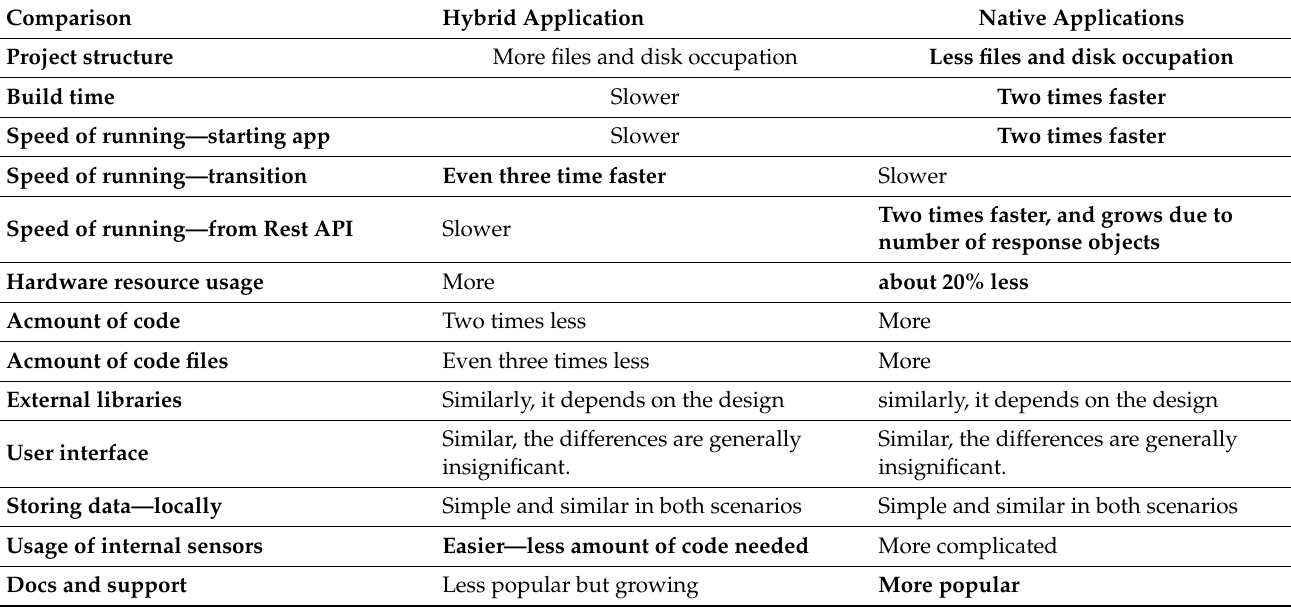
Table 8. Advantages and disadvantages of the tested technologies based on the conducted